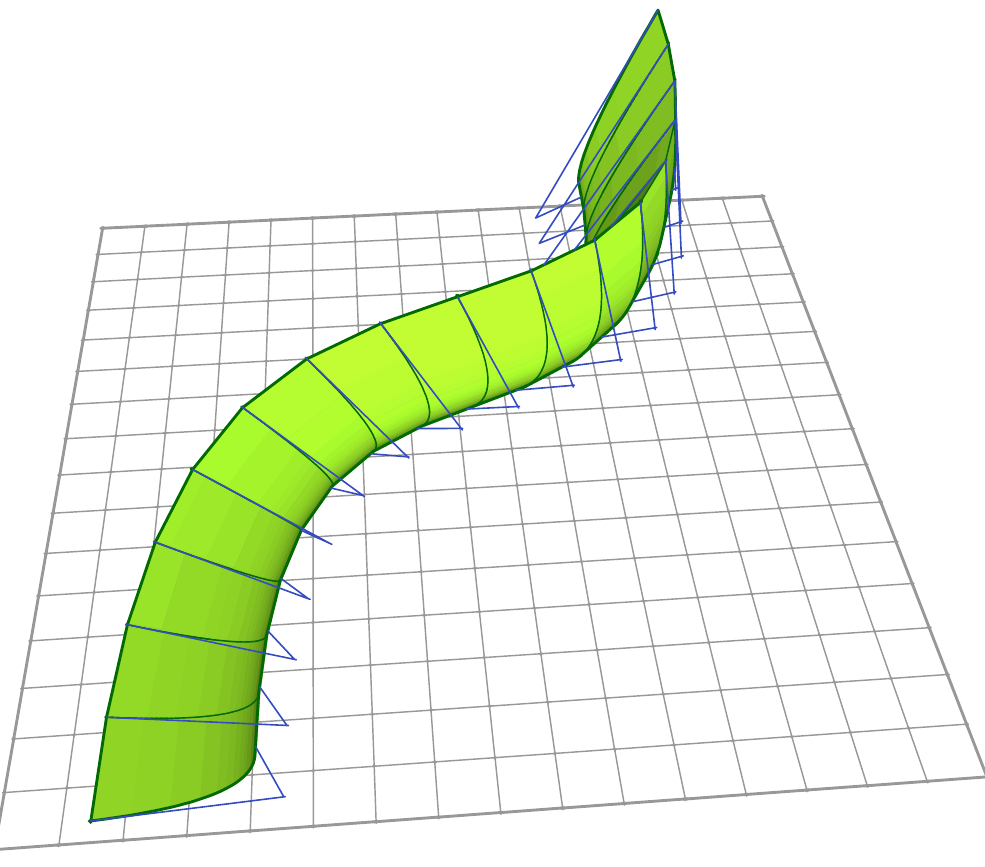
Figure 16. Developable surfaces created from geometry shown above, using method three.